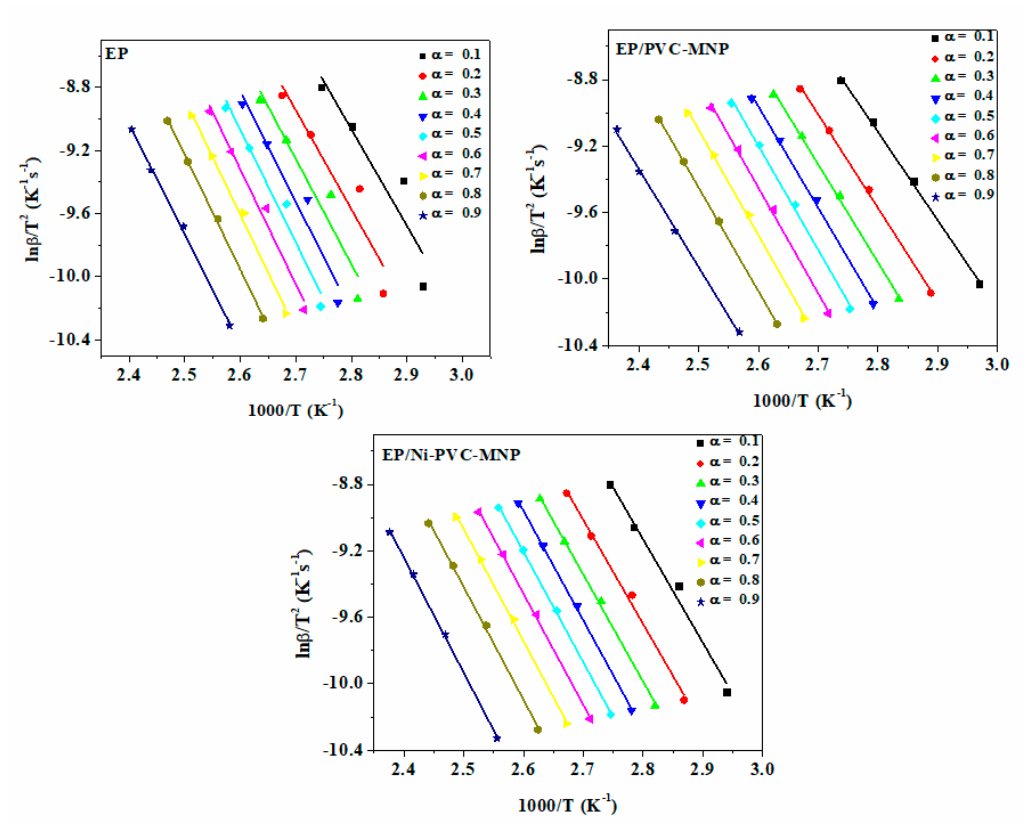
β / T 2 ) vs. 1 / T based on KAS model at β = 5 ◦ C / Figure A2. Fitting curves of ln( β /T 2 ) vs. 1/T based on KAS model at β = 5 °C/min. Figure A2. Fitting curves of ln(